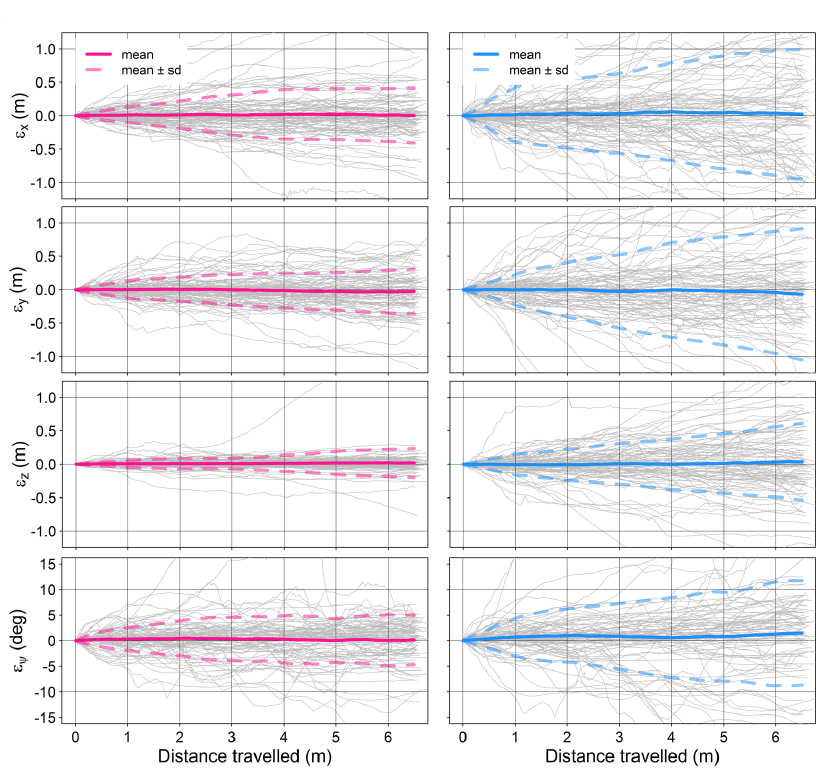
Figure 5. Translation and angular errors (shown for yaw only) over a sample of approximately one hundred 6.5 m-long trajectories for sparse (left column) and dense (right column) visual odometry.